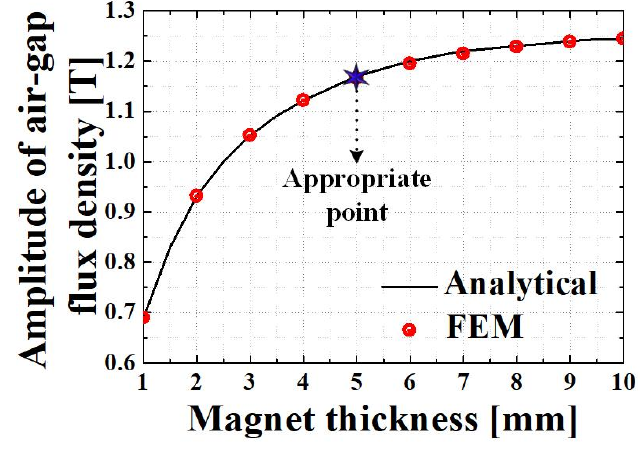
Figure 5. FFT analysis according to magnet thickness.